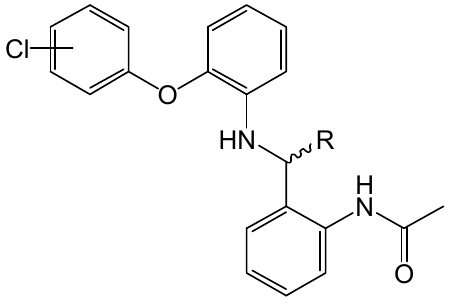
Figure 8. Novel C -substituted benzylamine linkers.